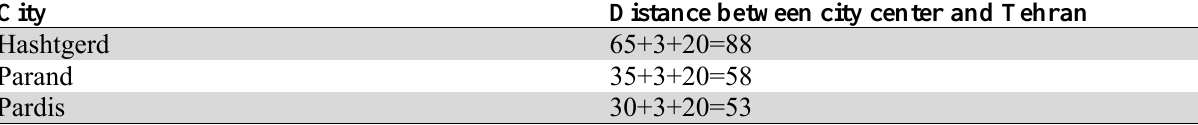
The distances that individuals travels daily between workplace and home has been shown in